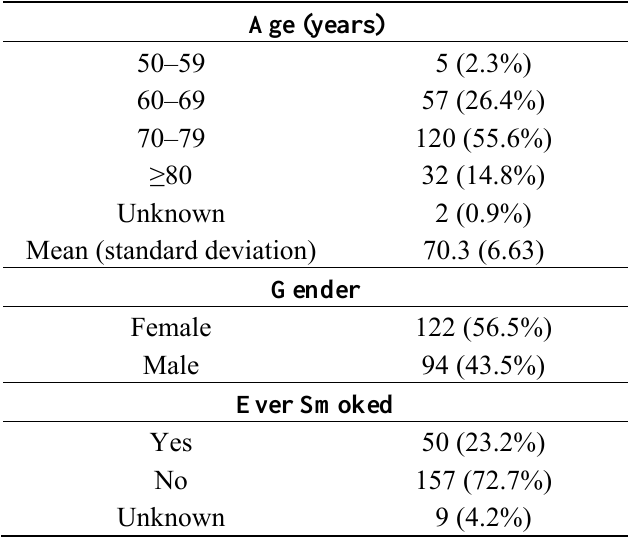
Table 1. Characteristics of study subjects ( N =